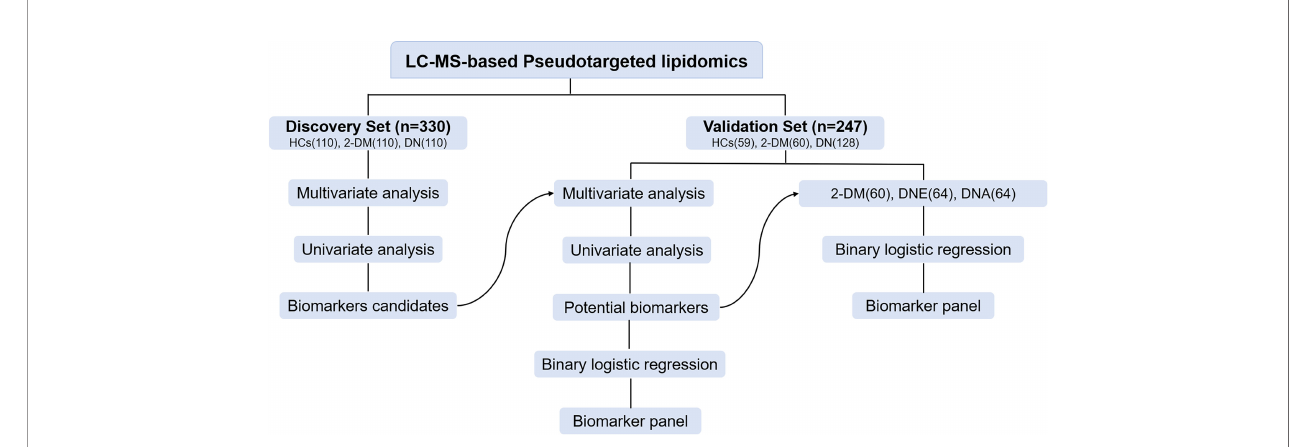
FIGURE 1 | Design of the